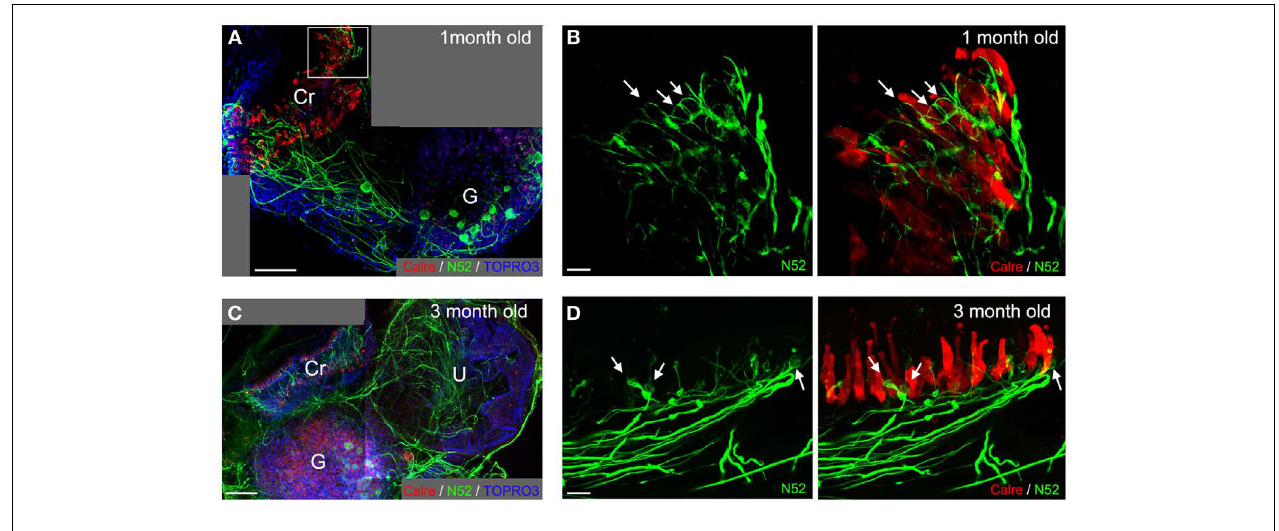
sensory epithelia. At higher magnification (B,D) , contacts between hair cells (red) and neurites were observed. Even calyceal terminals were observed (arrows) at both ages in the presence of PMA. Nuclei were stained withToPro3, blue in (A,C) . Scale bars 100 μ m in (A,C) and, 10 μ m in (B,D)